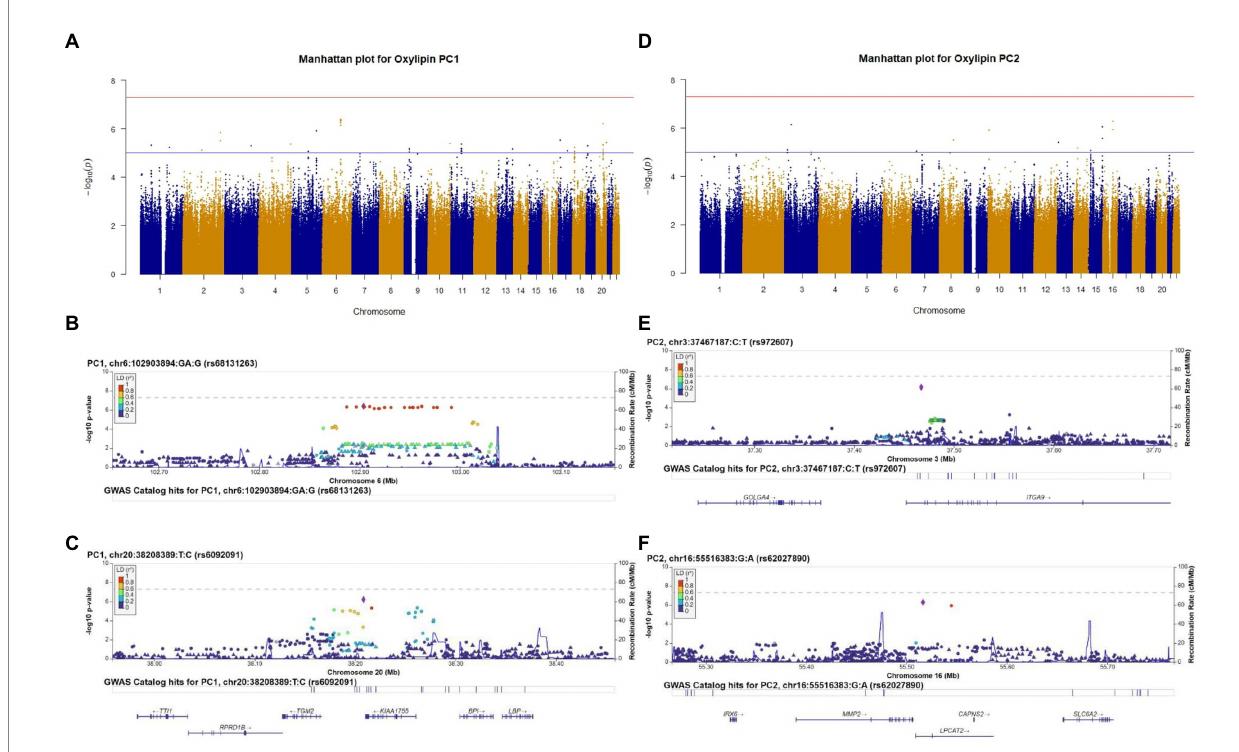
FIGURE 1 Genome-wide association study (GWAS) results of oxylipin PC1 (A) and oxylipin PC2 (D) , adjusted for sex and ancestry. Suggestive significance (value of p <5 × 10 − 5 ) is noted by the blue line, and genome-wide significance (value of p<5 × 10 − 8 ) is noted by the red line. We selected the two lead SNPs from oxylipin PC1 and PC2 that met suggestive significance for regional plots. Regional plots are for oxylipin PC1 (B,C) and PC2 (E,F) . Chromosome and physical location (Mb) are on the X-axis. Negative base ten logarithm of the value of ps is on the left Y-axis, and recombination activity (cM/Mb) is shown on the right Y-axis as a blue line. Positions, recombination rates, and gene annotations are according to NCBI’s build 38 (hg 19) and the 1,000 Genomes Project Phase 3 multiethnic data set. LD is calculated for a European population. Plots display +/ − 500,000BP of the selected SNP.